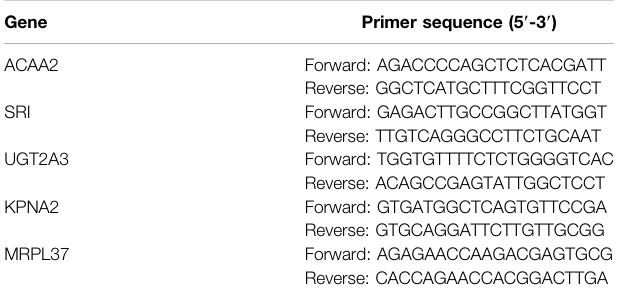
signi fi cant differences were screened for further analysis ( Figure 2B ). According to the tSNE algorithm, 1,092 CC cells were clustered into eight clusters, 5,224 marker genes were identi fi ed, and the top 10% of marker genes into each cluster were displayed on the heat map ( Figure 2C ). Eight clusters were annotated on the basis of marker genes: clusters 0/1/2/5/6/7 were cancer cells, cluster 3 was macrophages, and cluster 4